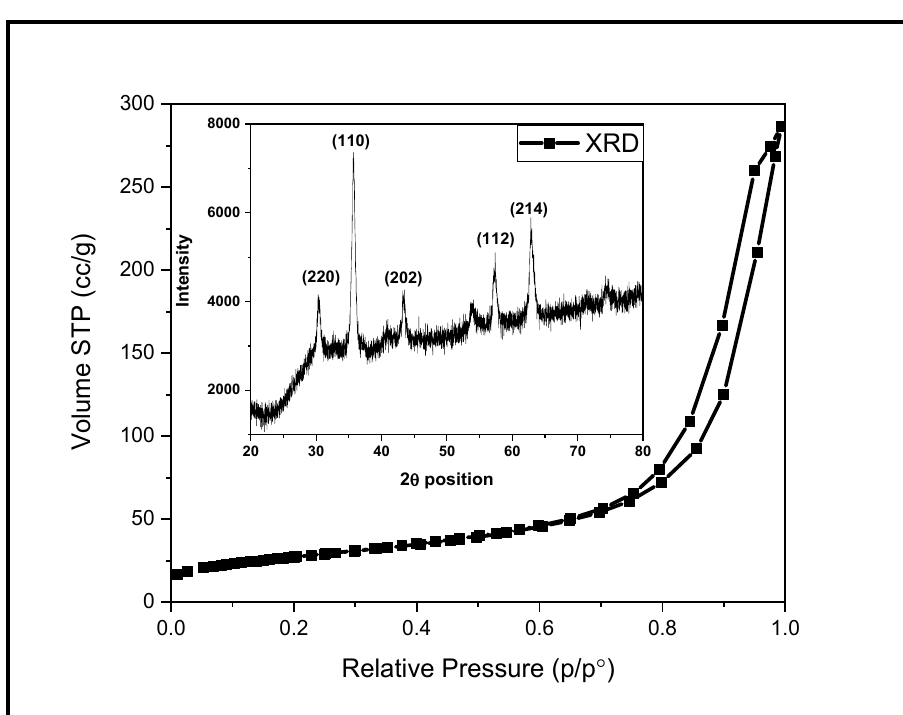
Figure 1. N 2 adsorption-desorption isotherm (inset: XRD pattern) of Fe 2 O 3 NPs.